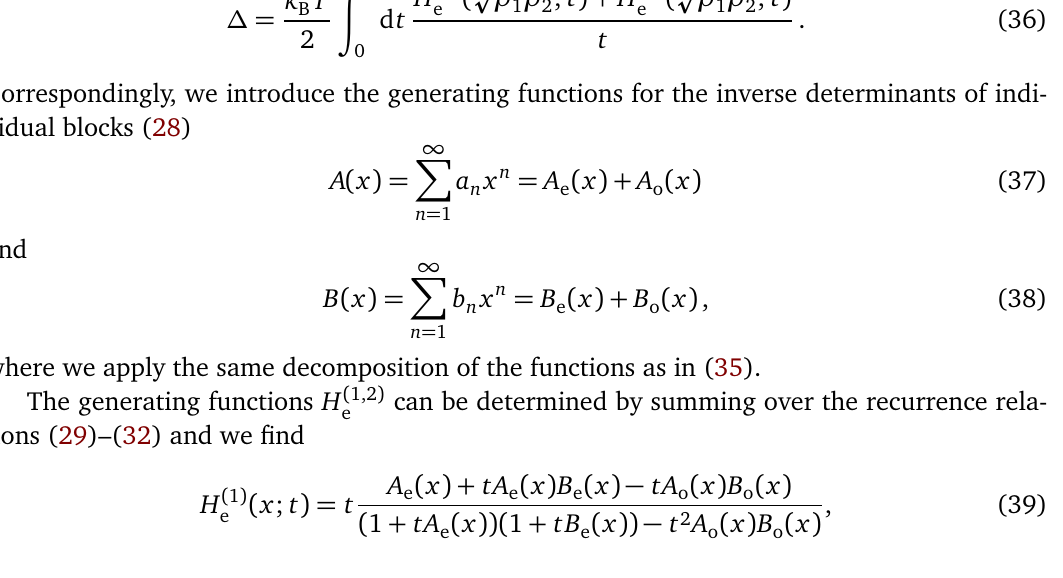
Figure 3: Diagrams for the configurations corresponding to diag ( m ( 1 ) ( 2 ) ( 2 ) ( 1 ) ) , diag ( m ( 2 ) m m m diag ( m 2 1 2 1 top to bottom. The diagrams on the right account for the three possible starting points of each partition, when considering a closed chain. The arrows indicate the starting points of the partitions. By circularly permuting diag ( m reproduce all four configurations. On a closed chain the four permutations appear naturally so that each diagram occurs four times on the right-hand